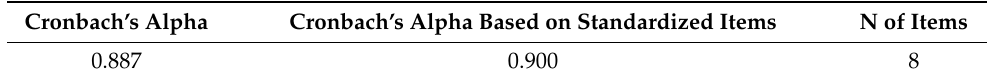
Table 7. Reliability statistics for the eight items in the survey.